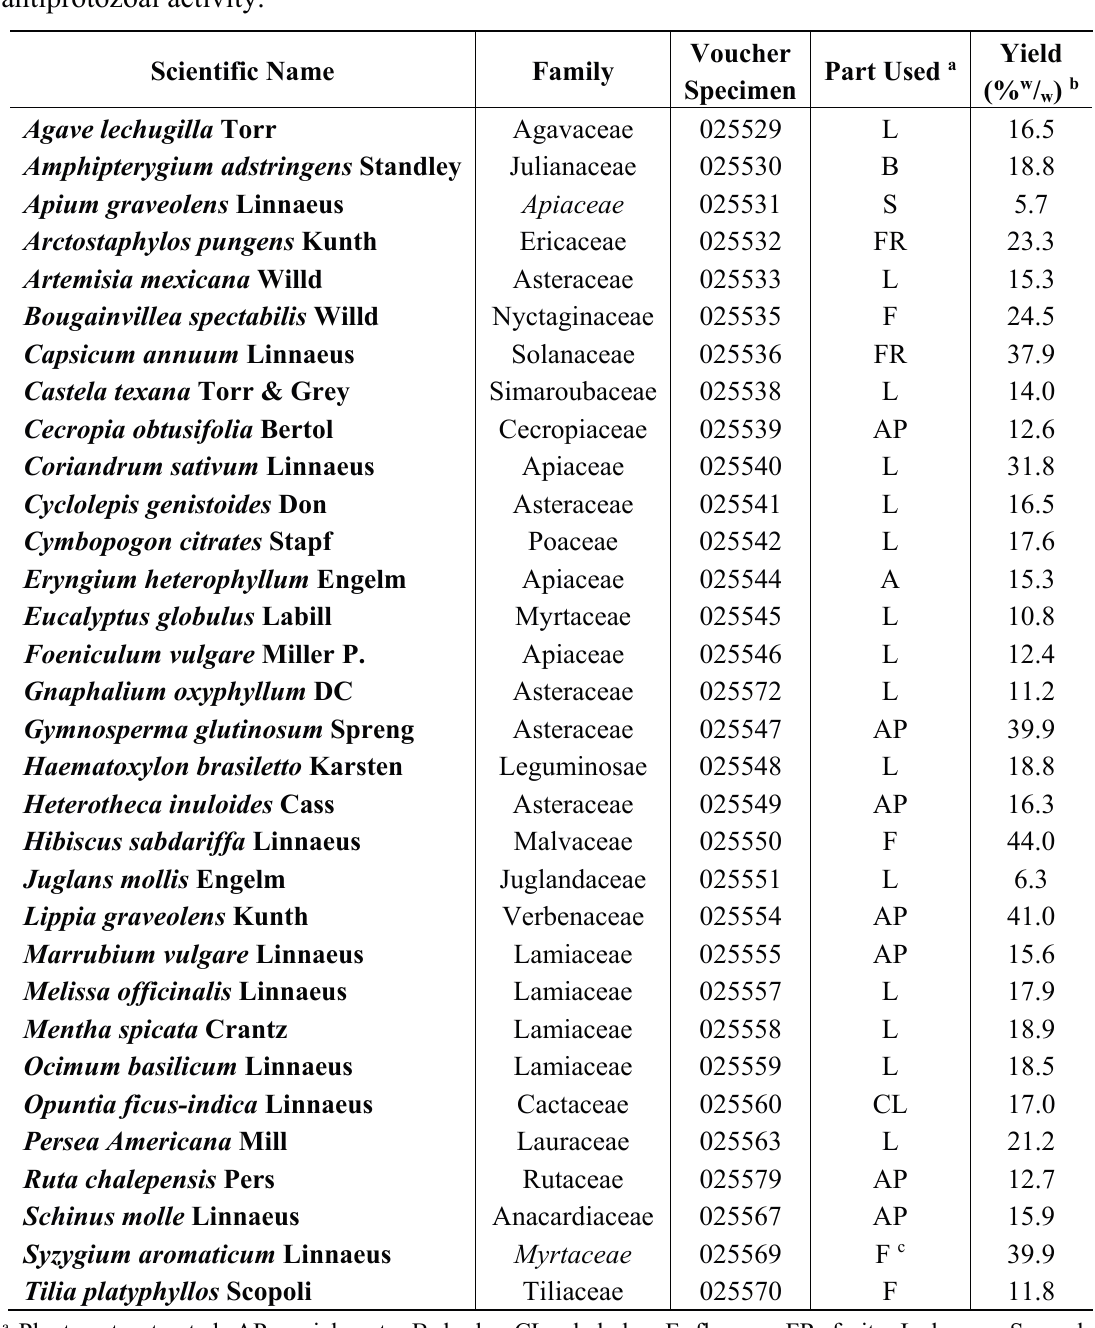
Table 1. Soxhlet extraction of medicinal plants used in Northeast Mexico investigated for antiprotozoal